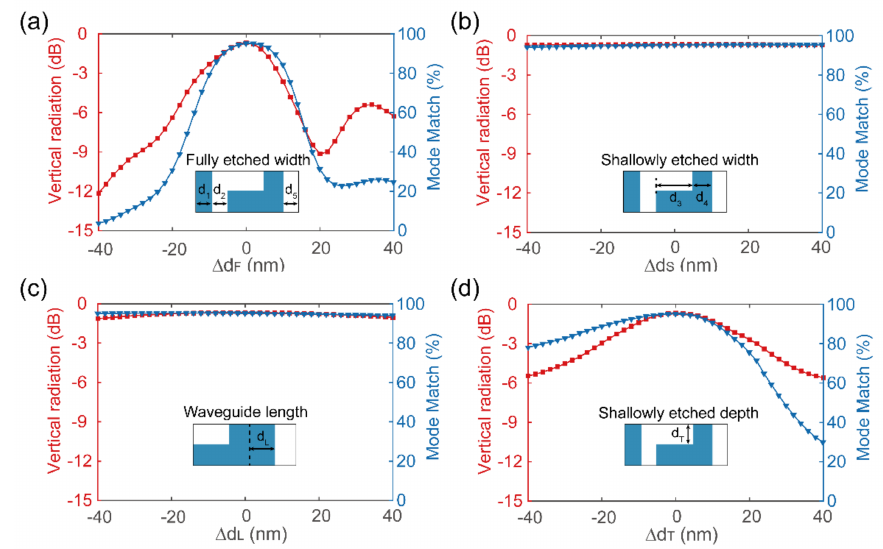
Figure 5. Fabrication tolerances of the vertical radiation and mode match. ( a ) Width error caused by full etching process. ( b ) Width error caused by shallow etching process. ( c ) Length error of connecting waveguide. ( d ) Depth error caused by shallow etching process.